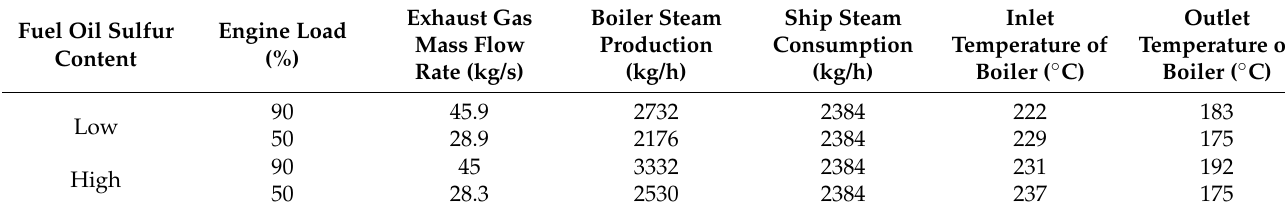
Table 6. Exhaust gas parameters at the outlet of the boiler in winter.